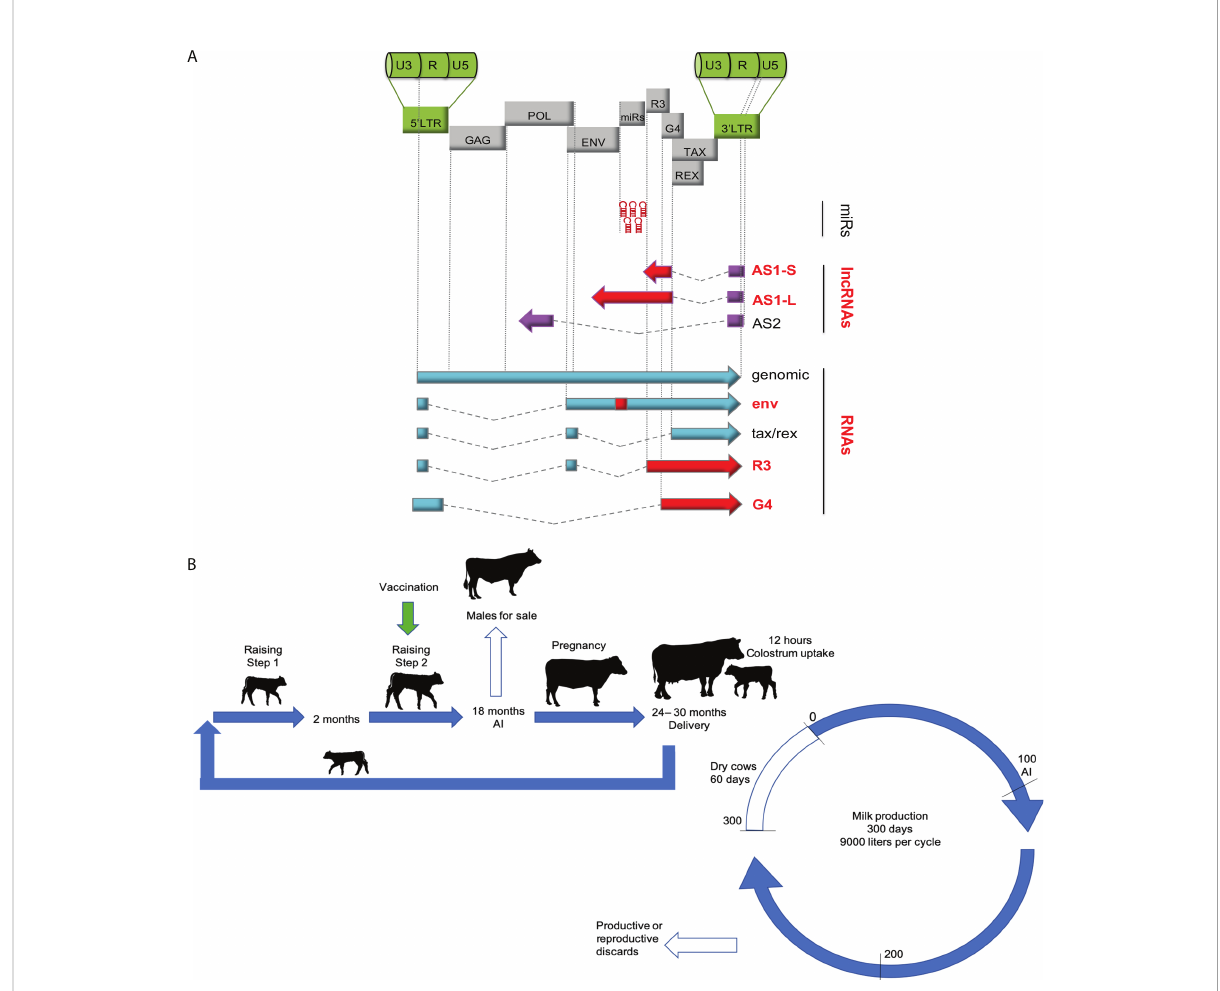
FIGURE 1 (A) The genetic map of the BLV vaccine strain. The pBLV6073DX provirus is isogenic to pBLV344 but contains a mutation in the env gene and deletions in AS1-S, AS1-L, R3 and G4 (red) (9, 10). The viral microRNAs are thus preserved in the vaccine strain. (B) Experimental plan of the vaccination trial in the dairy farm. The female calves were vaccinated once at 6 months (+/- 6 months) depending on the drop of anti-BLV antibodies conferred by passive immunity. Standard management practices were then followed in the milk producing herd. Male calves were sold at 18 months while heifers were arti fi cially inseminated (AI). After delivery, the calves suckled colostrum during 12 hours and were then placed in calf individual sticks and bucket fed with bulk-tank milk and balanced food for 60 days (step 1). Then, calves of similar age and weight were moved to pastures (step 2). The cows entered a production cycle during approximately 10 months. The cows underwent an average of 3.5 reproductive